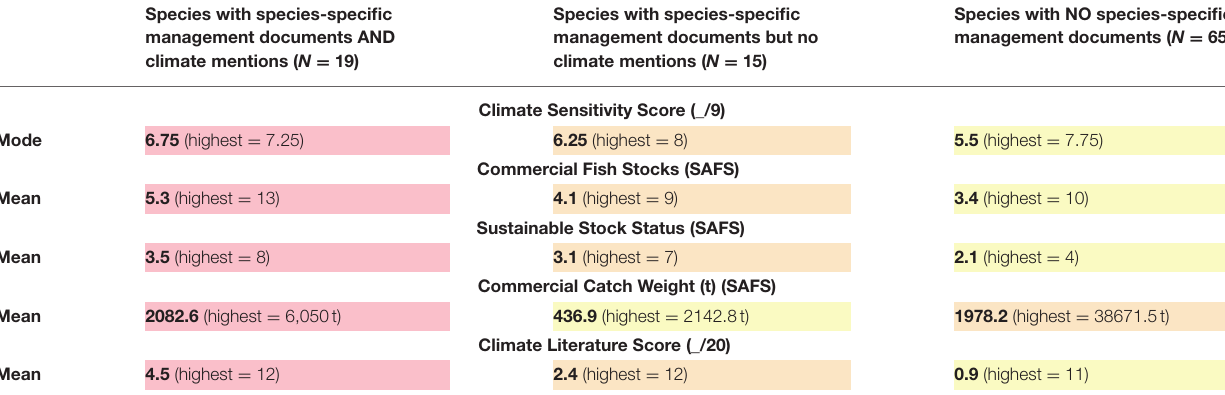
TABLE 3 | Mean/modal data for the Climate Sensitivity Score (i.e., a measure of species risk and capacity to respond to climate changes), Number of Sustainable Fish Stocks, Number of Commercial Fish Stocks, and Commercial Catch Weight, for the 99 Australian fisheries species, divided into three categories based on whether they had species-specific management documents and Climate Mentions within those management